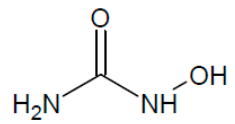
Figure 4. Hydroxyurea structure